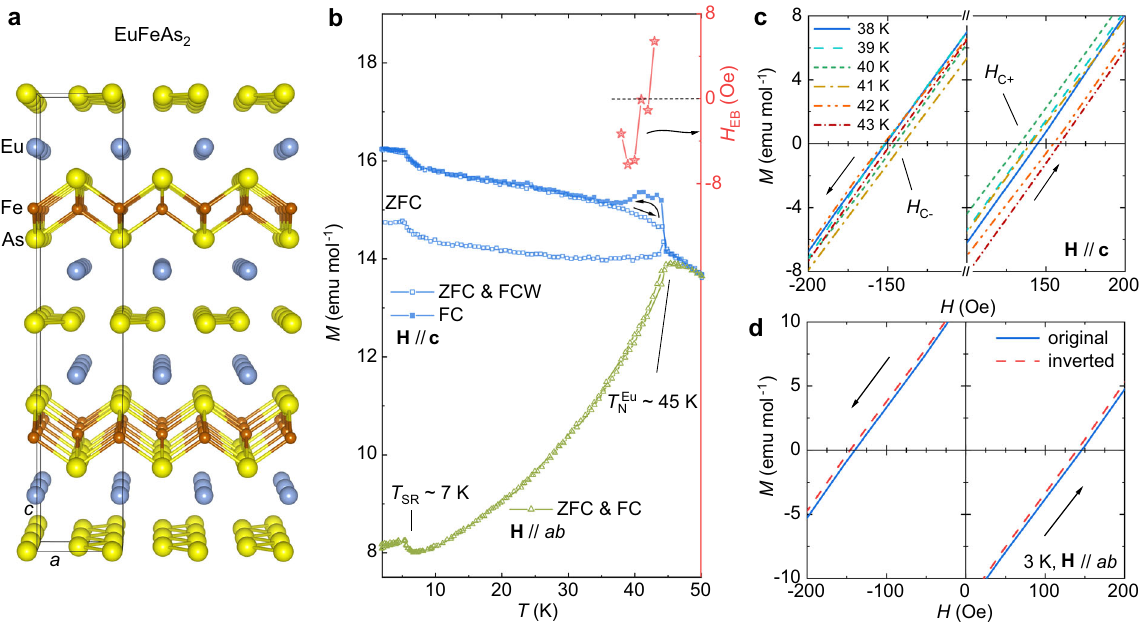
Fig. 1 Crystal structure and magnetic properties of EuFeAs 2 . a Schematic diagram of the crystal structure 12 . b Magnetization against temperature under a magnetic fi eld of 100 Oe. c , d Magnetization against the magnetic fi eld at different temperatures with fi elds parallel to the c direction and the ab plane, respectively. The stars to the right axis in ( b ) represent the EB fi elds of the hysteresis loops in ( c ). The original curve in ( d ), solid, is the obtained M – H curve. The inverted curve, dashes, is the centrosymmetric one of the